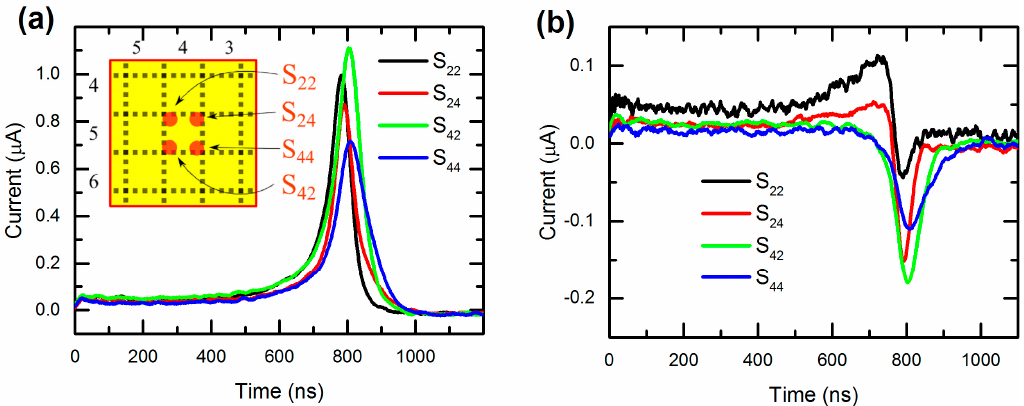
Figure 8. Individual current waveforms measured on ( a ) CP and ( b ) GR when illuminating symmetrical spots at 400 V bias.